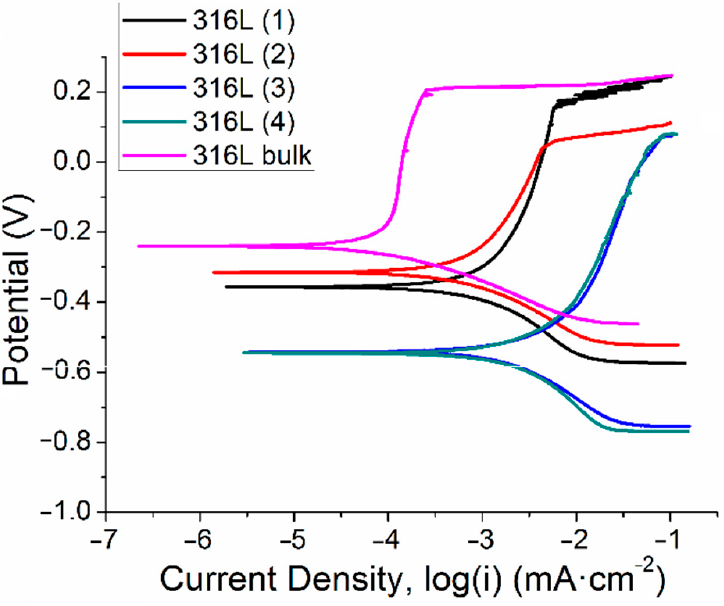
Figure 8. Tafel slopes of 316L coatings and bulk. Table 5. Results of corrosion testing and abrasion rate for 316L CGS coatings and bulk.